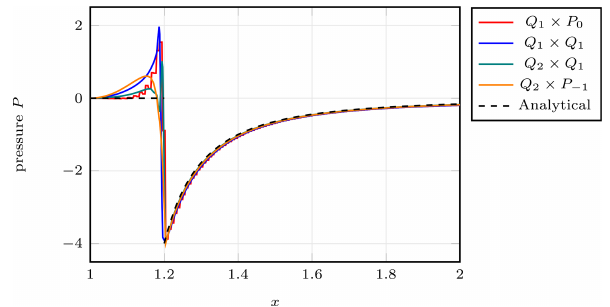
Figure 10. SolVi benchmark. Pressure on the horizontal ray starting from the center of the inclusion at x =